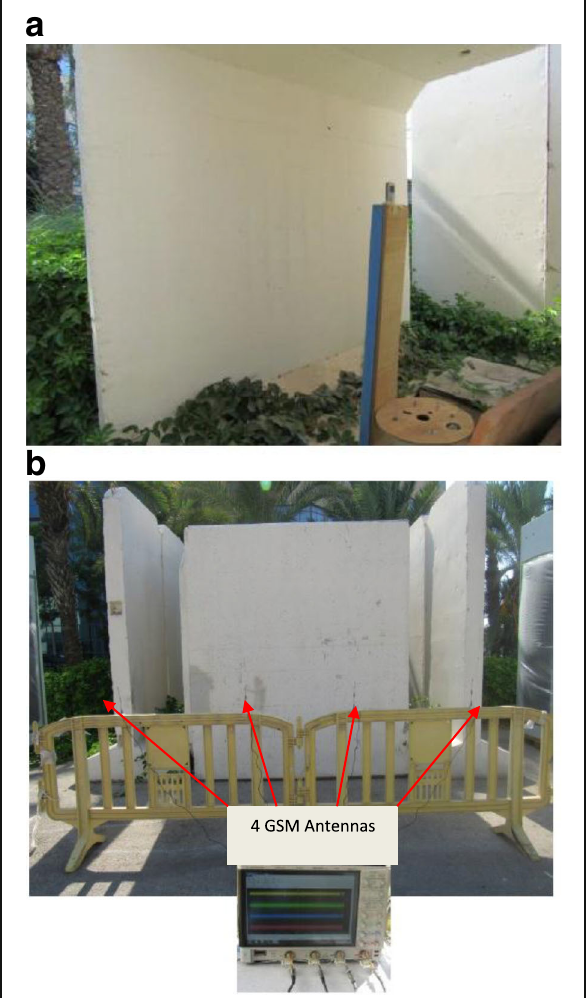
Fig. 11 Outdoor experimental setup: ( a ) indoor GSM cellphone; ( b ) outdoor antenna array